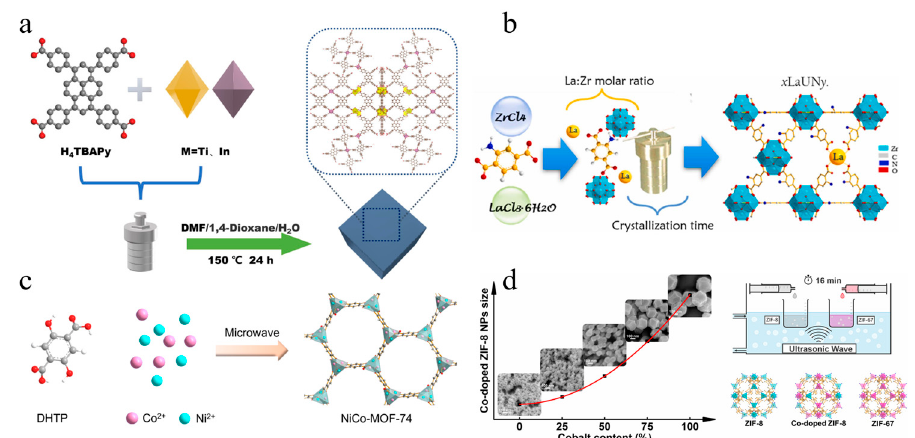
Figure 2. ( a ) Schematic representation of the synthesis of Ti-In-MOFs. Adapted with permission from Ref. [40], 2023, Elsevier; ( b ) La-Zr MOFs. Adapted with permission from Ref. [41], 2023, Elsevier; ( c ) NiCo-MOF-74. Adapted with permission from Ref. [42], 2023, Elsevier; ( d ) Co/ZIF-8. Adapted with permission from Ref. [43], 2023, Elsevier.